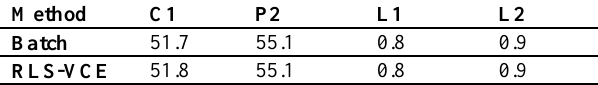
Fig. 2 Estimated standard deviations of GPS phase observations (L1 and L2) for Trimble R7 receiver in mm for both batch and recursive methods Table 2 Estimated standard deviations of four GPS observation types for both solution forms in mm